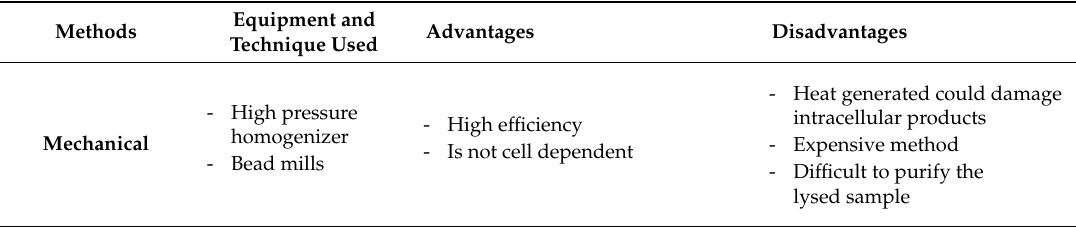
Table 3. Overview and comparison of cell lysis